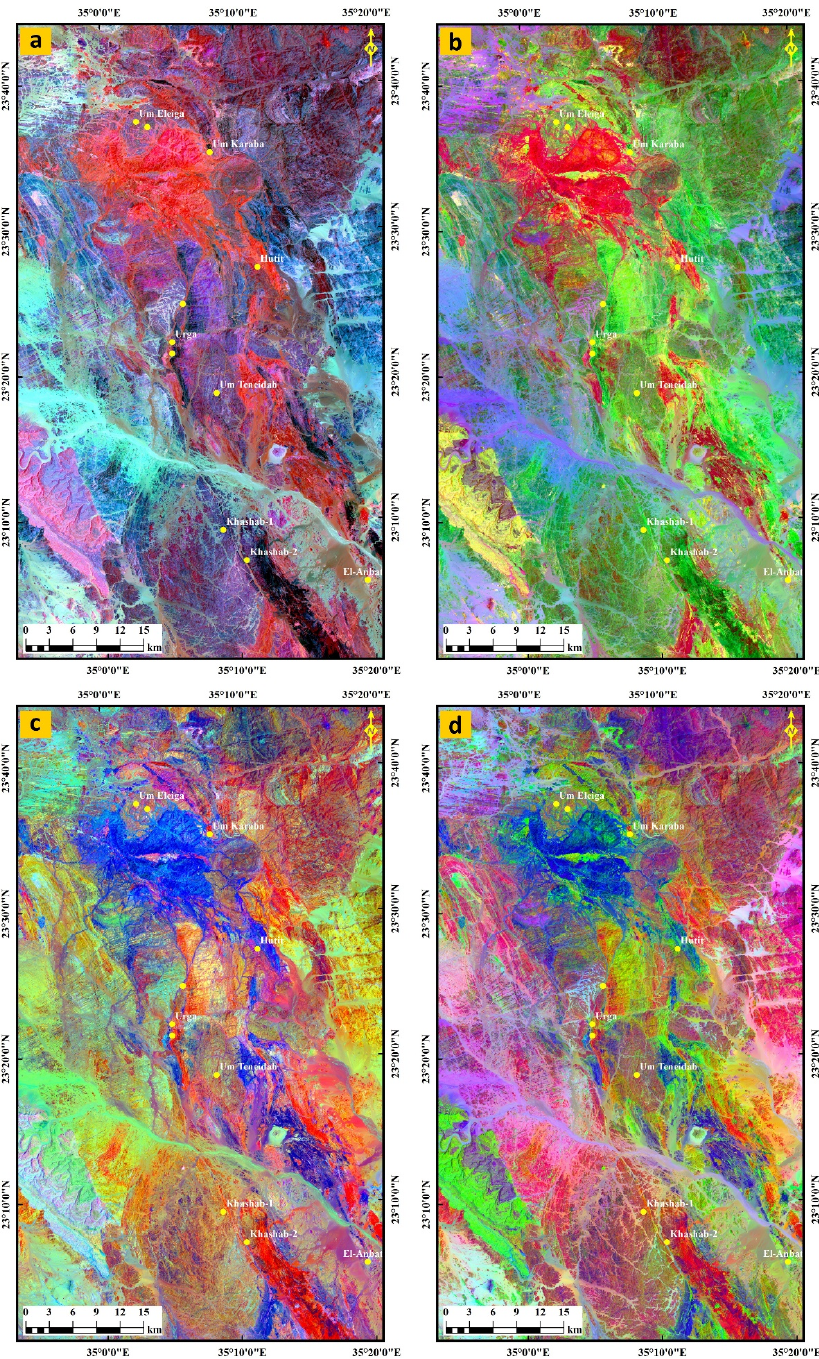
Figure 4. Spectral discrimination of ophiolites and related rocks using processed Landsat-8 ( a ) Abrams ratio (RGB-6/7, 4/3, 5/4), ( b ) Chica-Olma ratio (RGB-6/7, 6/5, 4/2) and ( c ) Kaufmann ratio (RGB-7/5, 5/4, 6/7). ( d ) Decorrelation stretching to (7-6-5). The NW-thrusted contacts and E–W strike slip faults can be detected from the three image ratios (Figure 4a–c). Moreover, decorrelation stretching is an important image en- hancement method that is used to improve visual interpretation of satellite images [51].